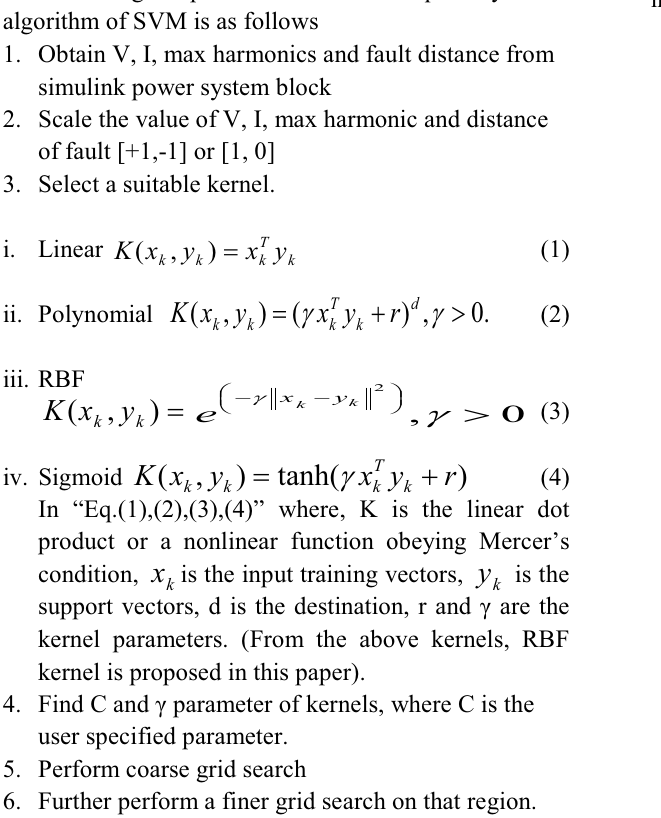
Fig. 4. Proposed method’s flow